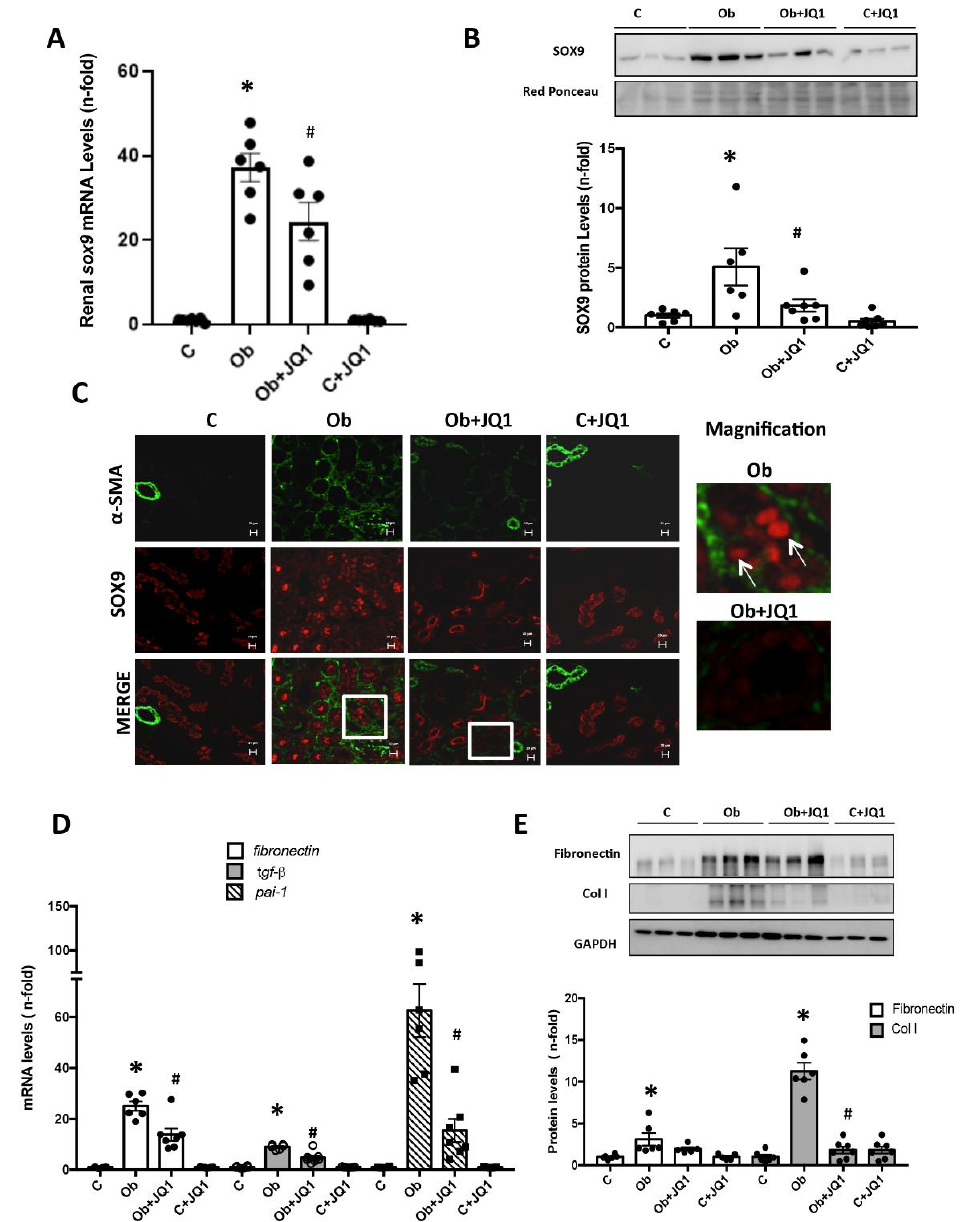
Figure 10. Inhibition of BET proteins by JQ1 prevents kidney SOX9 and ECM overexpression induced by UUO. ( A , B ) Gene and protein expression levels of SOX9 were evaluated by real-time qPCR ( A ) and Western blot ( B ). ( C ) The nuclear localization of SOX9 and its relationship with the extracellular matrix was evaluated by immunofluorescence. D, E) Inhibition of BET proteins by JQ1 decreases profibrotic markers in murine UUO such as ( D ) Fibronectin , Pai-1 , and Tgf- β 1 , evaluated by real-time qPCR, or ( E ) The protein levels of Fibronectin and Type I Collagen (COLI) determined by Western Blot. Data are expressed as the mean ± SEM of 6–8 animals per group and scale bar represents 20 µ M. * p < 0.05 vs. contralateral; # p < 0.05 vs. obstructed kidneys treated with JQ1.